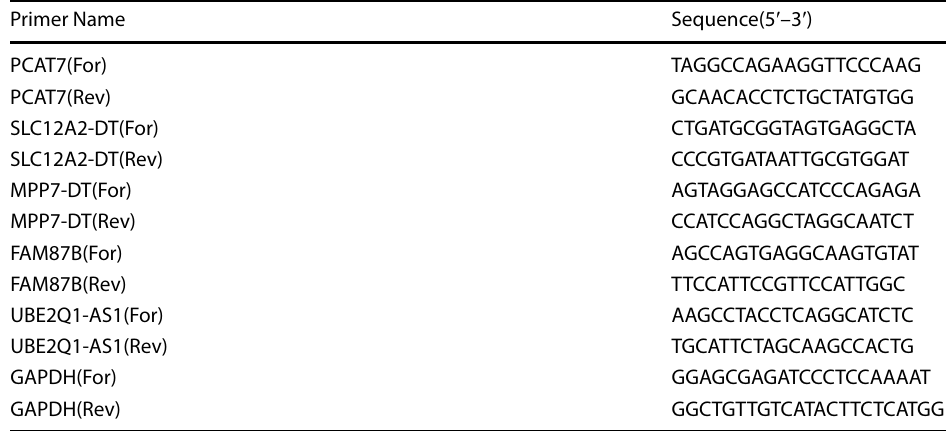
Table 1 primer sequences used in the qRT-PCR